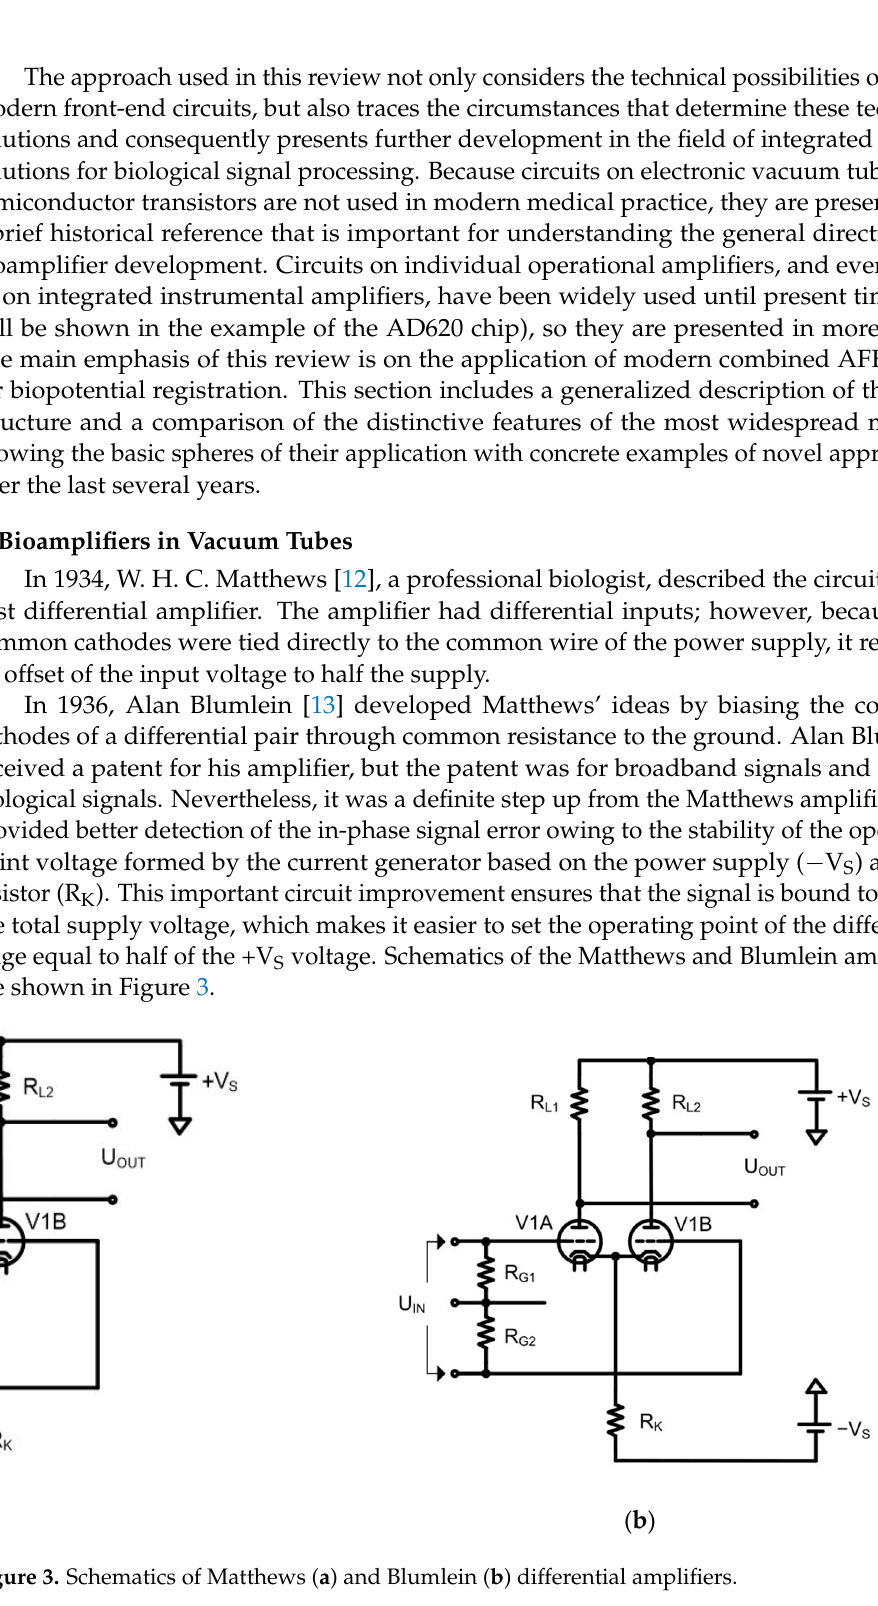
Figure 4. The first vacuum tube differential bioamplifier cascade under US patent no. 2,147,940 [10]. An example of the differential between the input and output bioamplifiers on elec- tronic vacuum tubes is shown in Figure 5 [14]. This bioamplifier contains two differential